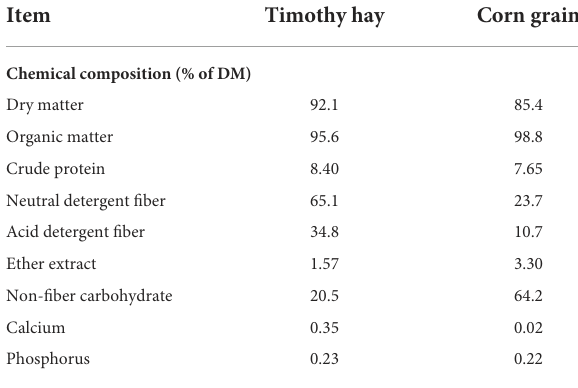
TABLE 1 Chemical composition of substrates used in the in vitro experiment.